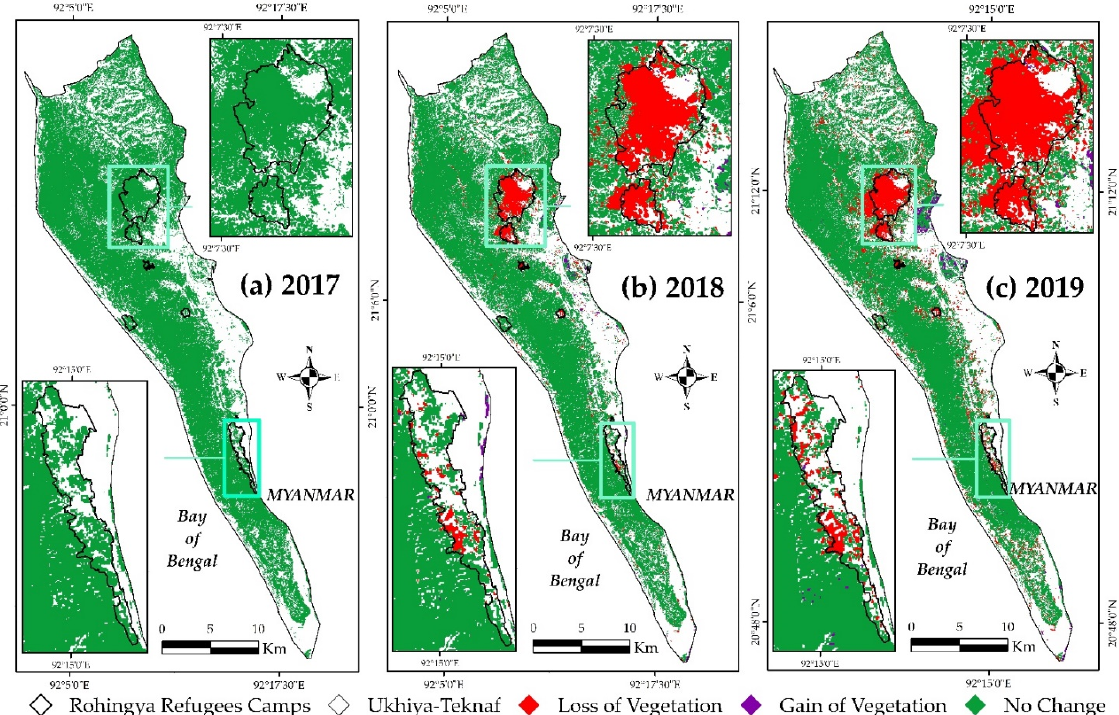
Figure 15. Spatiotemporal changes of vegetative cover, pre and post refugee crisis, Ukhiya-Teknaf: ( a ) Vegetative cover before the refugee influx in 2017, ( b ) loss of vegetative cover after the refugee influx in 2018, ( c ) rapid loss of vegetative cover due to the refugee influx in 2019. Green, red, and violet colors represent no change, total loss, and total gain, respectively, by the period of